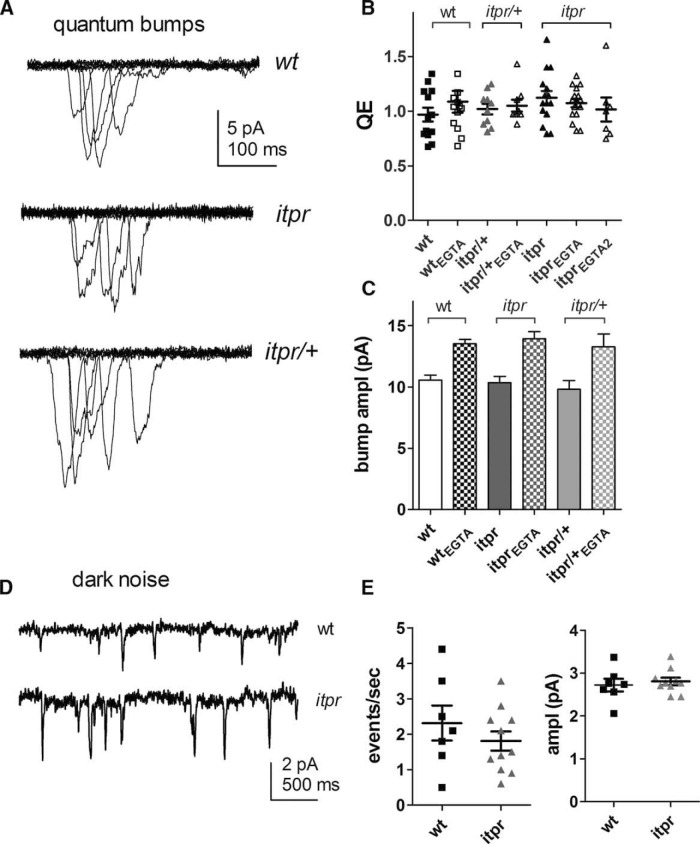
Whole-cell recordings from itpr-null mosaics. A, Quantum bumps: 10 superimposed traces (including failures) from responses to 1-ms flashes containing on average ∼0.5 effective photons, recorded with 1 mm EGTA in electrode in wild-type, itpr mosaic null, and itpr/+ heterozygotes (sibling controls). B, Summary of QE in recordings with and without EGTA, normalized to wild-type values. There was no significant effect of EGTA or itpr-null mutation (mean ± SEM; itpr control electrode solution, n = 15 cells; itpr recorded with 1 mm, n = 15; 2 mm EGTA, n = 7; wt and itpr/+ controls, 9–14 cells; p = 0.77, one-way ANOVA). C, Mean bump amplitude was increased in recordings made with EGTA (n = 4–10 cells). D, Dark noise recorded in wild-type and itpr mutants recorded using normal electrode solution (no EGTA); both showed similar levels of dark noise. E, Dark event rates and amplitudes (mean ± SEM) in wild-type (n = 7 cells) and itpr mosaics (n = 11 cells) were similar (p = 0.34 for rates and 0.64 for amplitude, two-tailed t test).